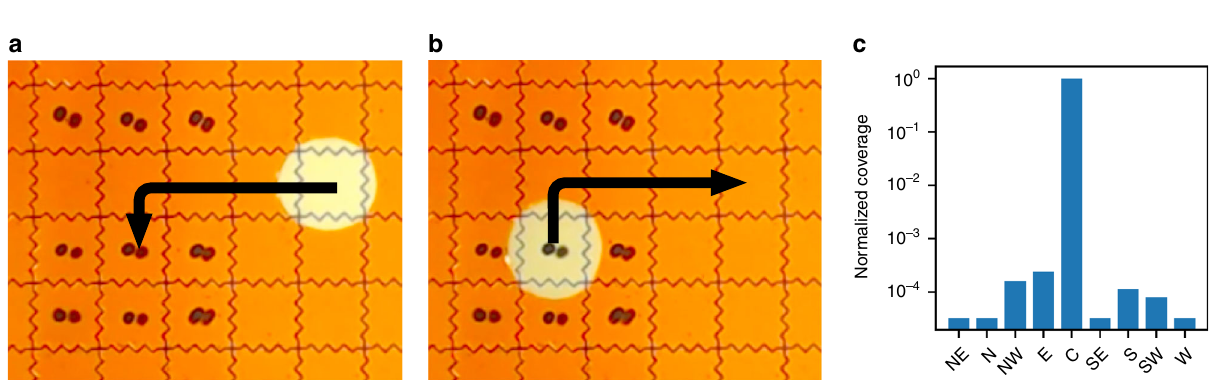
Fig. 4 DMF setup for neighbor contamination tests. a Nine uniquely indexed pools are spotted onto a 4 x 3 electrode array with a central row left as an empty path for the recovery droplet. Cardinal directions of fi le locations are in reference to the central target spot. A droplet is moved to the central storage pool. b The droplet with reconstituted fi le returns to starting point for manual retrieval and analysis. c NGS coverage of each discovered fi le in cardinal coordinates (log scale) as seen in Table